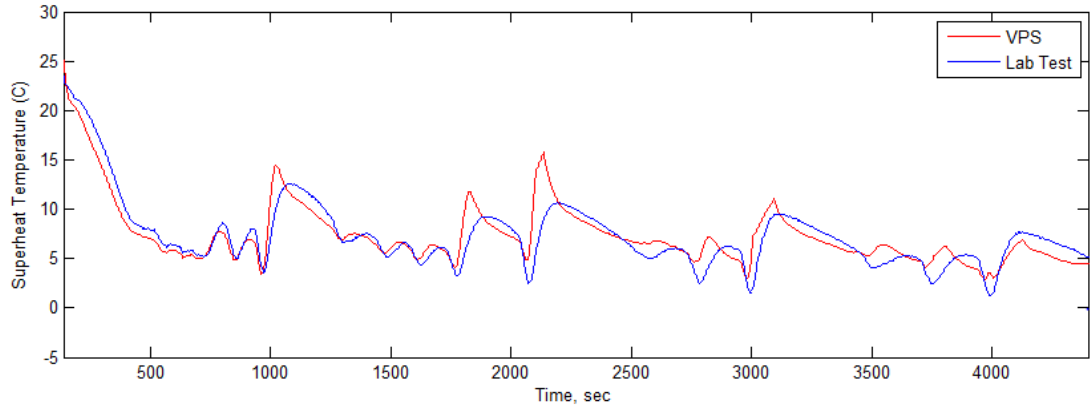
Figure 5. Test Case 2—superheat temperature estimation: VPS vs. test.